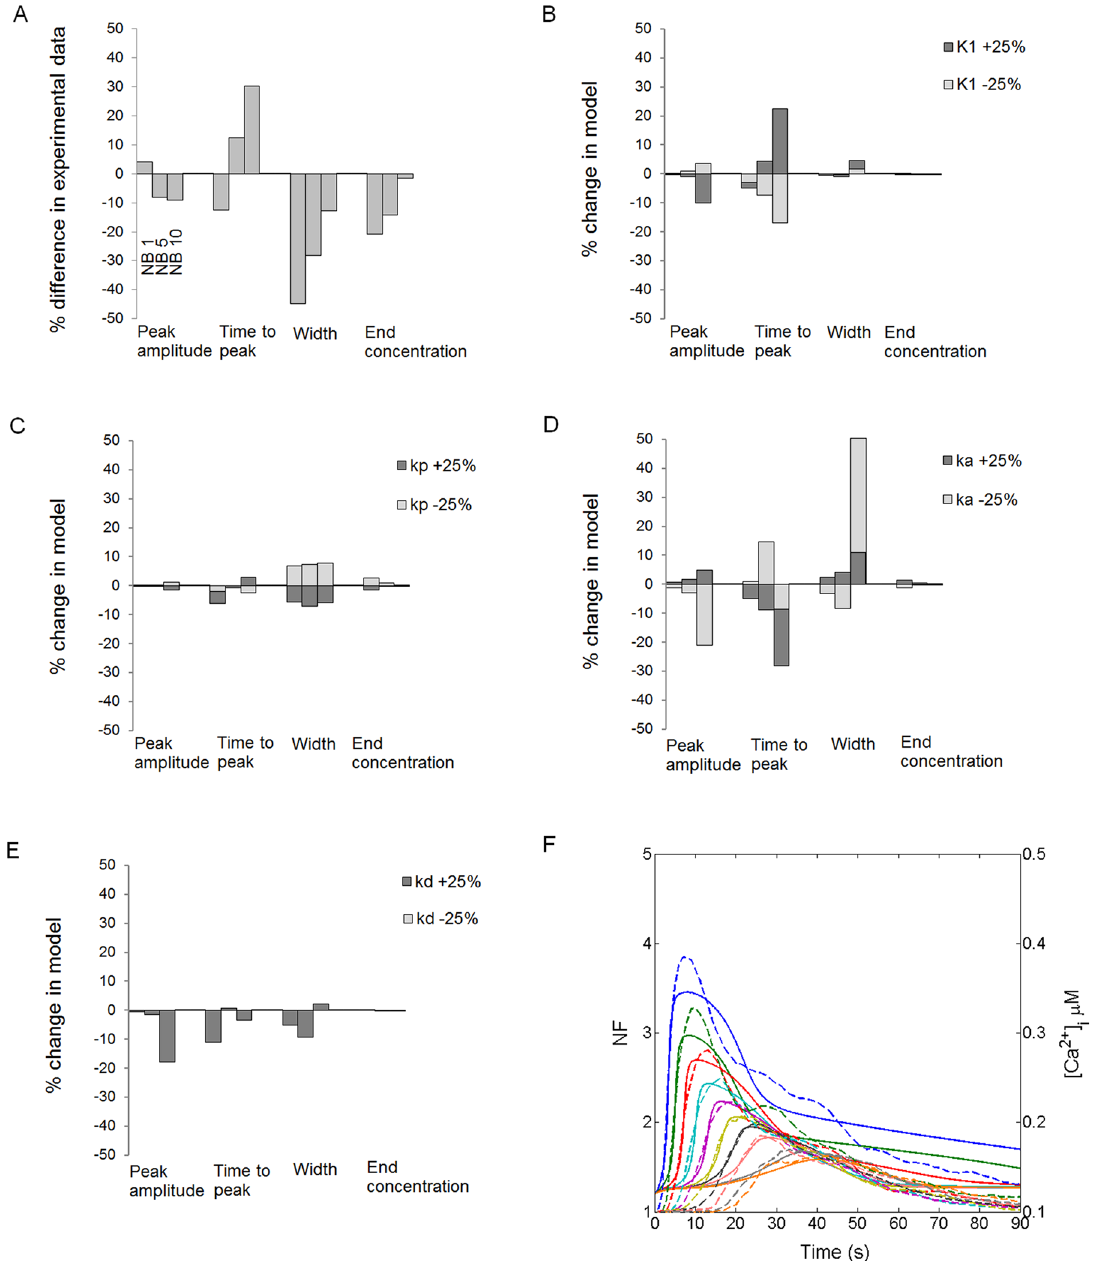
Fig 7. Suramin effects on Ca 2+ wave. (A) Comparison of the peak amplitude, time to peak, Ca 2+ wave width at half maximum, and end Ca 2+ concentration at 90 seconds ’ time point in cell layers NB1, NB5 and NB10 between the experimental GA-treated and GA-suramin-treated data sets. The deviations of each Ca 2+ wave feature in GA-suramin-treated data set from GA-treated data set are expressed as percentages. (B) Unphosphorylated P 2 Y 2 receptor dissociation constant (K 1 ), (C) P 2 Y 2 receptor phosphorylation rate (k p ), (D) G-protein activation rate (k a ), and (E) G-protein deactivation rate (k d ) were changed in the model for GA-treated data set either -25% or +25%, as denoted in the grayscale of the histogram, and the percentage change in each Ca 2+ wave feature is illustrated. (F) Fitting of the model to the GA-suramin-treated data set. Dashed lines represent the data in dimensionless NF units, whereas solid lines represent the model simulations with arbitrary units representing [Ca 2+ ] i in μ M concentrations. The uppermost curve pair (blue) represents NB1, the second uppermost NB2 (green), followed by NB3 (red), NB4 (light blue), NB5 (purple), NB6 (yellow), NB7 (black), NB8 (light red), NB9 (grey), and NB10 (orange).